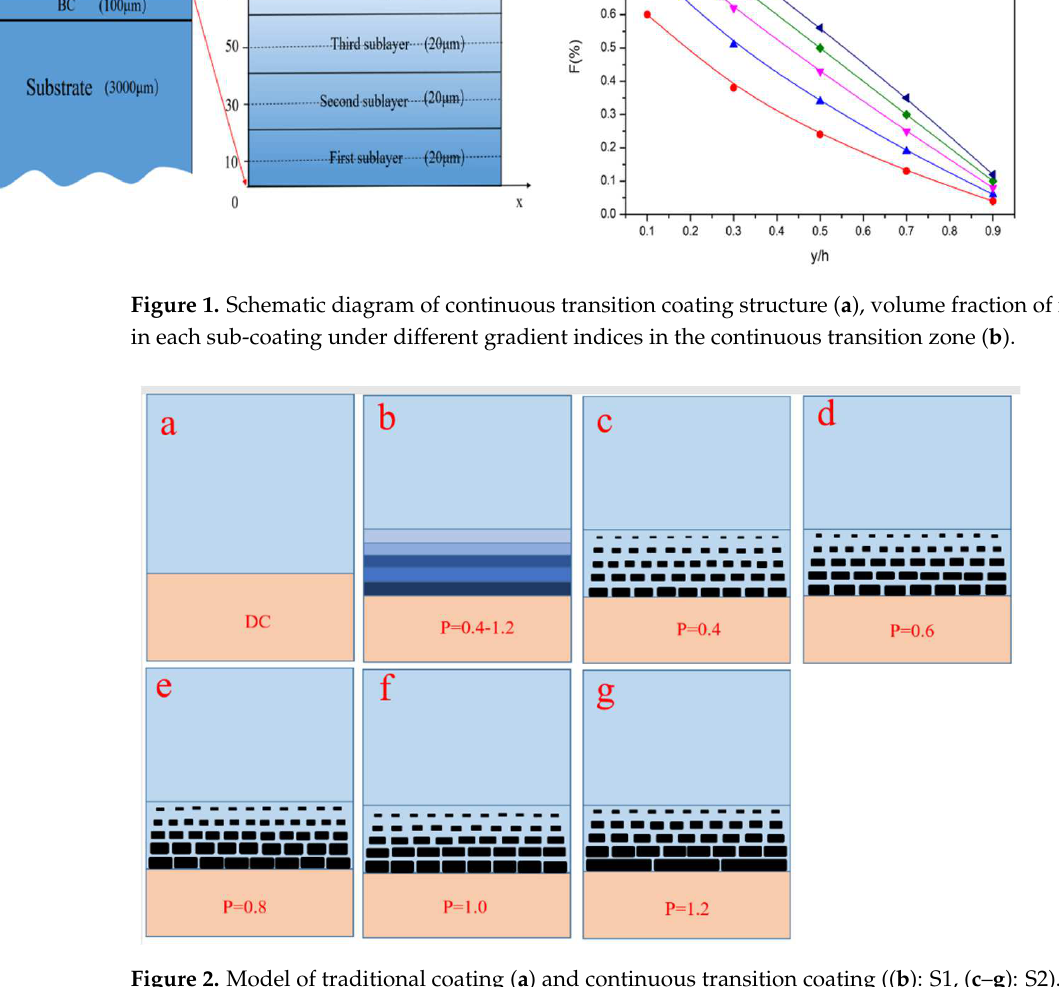
Figure 2. Model of traditional coating ( a ) and continuous transition coating (( b ): S1, ( c – g ): S2).